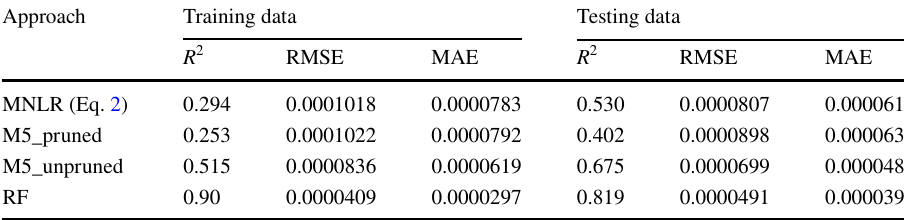
Approach Training data